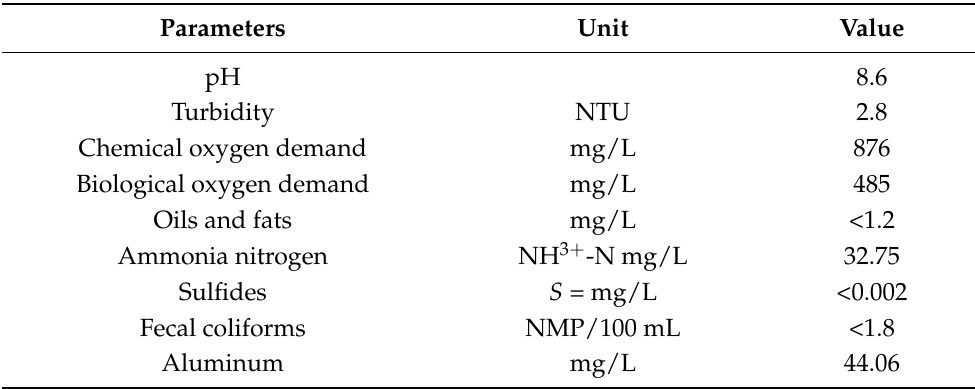
Table 6. Results of the physicochemical characterization of the treated sample.